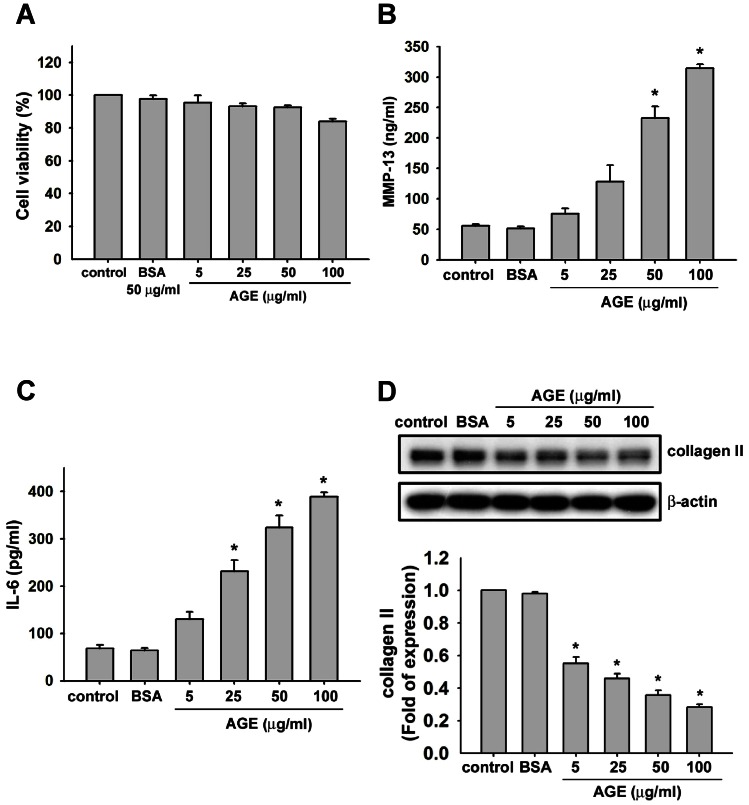
AGEs induce inflammatory signalings in human OA chondrocytes.Human OA chondrocytes (1×106/ml) were incubated with AGEs (5–100 µg/ml) for 24 hours and cytotoxic effect was determined by MTT assay (A). Productions of MMP-13 (B) and IL-6 (C) were quantified by the ELISA kits. Protein expressions of collagen II (D) were determined by Western blotting. Densitometric analysis for collagen levels corrected to β-actin is shown. All data are presented as mean ± SEM for three independent experiments. *: P<0.05 versus control.